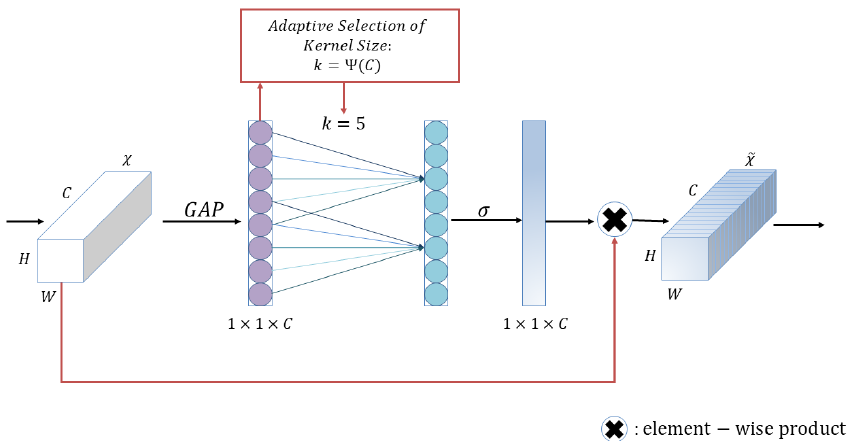
Figure 2. Illustration of efficient channel attention